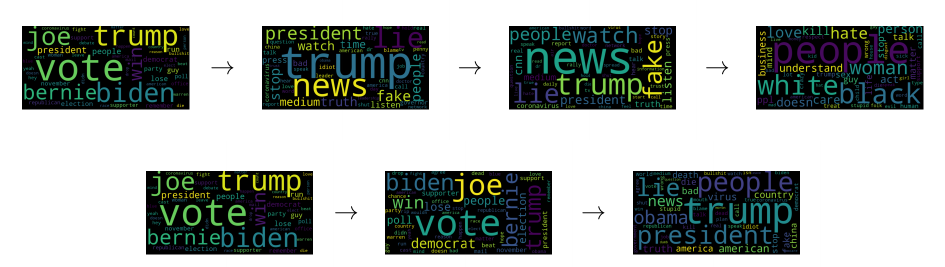
Figure F.1. Top word clouds showing evolution of topics on the presidential election topic paths computed via the shortest path algorithm (bottom) and the TopicFlow (top) algorithm. The sample timestamps at which the topics are learned are March 23, 24, 27, and May 15 (top); March 23, 27, and May 15 (bottom). Note that the shortest path algorithm produces much smoother and more intuitive transitions among topics within a general